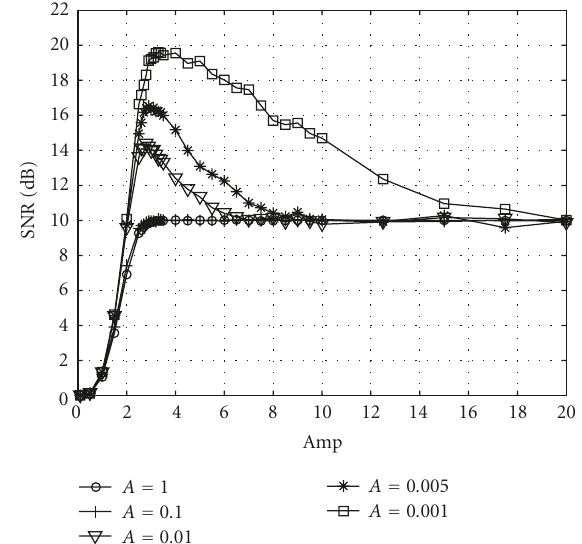
Figure 5: SNR versus Amp for various A values (rate = 1 . 0, GIR = 0 . 1, σ 2 = 0 .